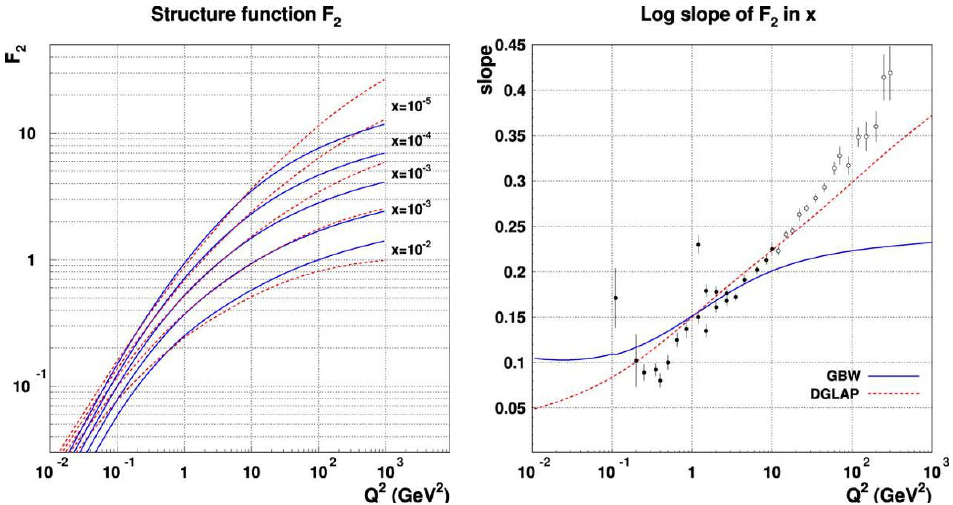
Figure 5 . Left plot: F 2 for fixed values of x as a function of Q 2 for the GBW (solid line) and DGLAP improved (dashed lines) models. The logarithmic slope in x of F 2 as a function of Q 2 is shown in the right plot for the same models. The experimental points are from ref.